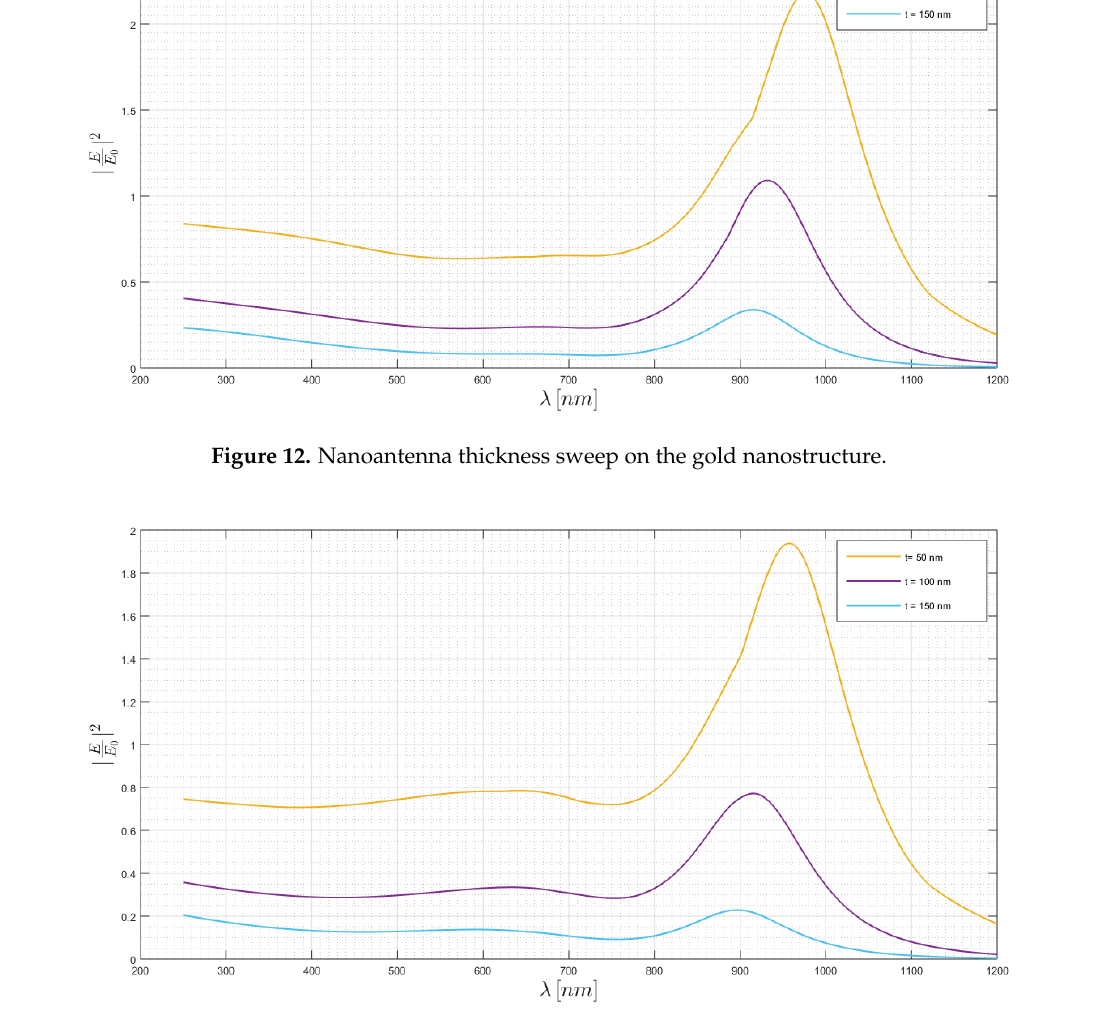
Figure 13. Nanoantenna thickness sweep on the copper